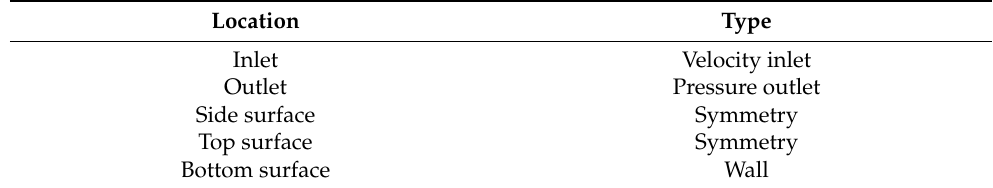
Table 6. Boundary